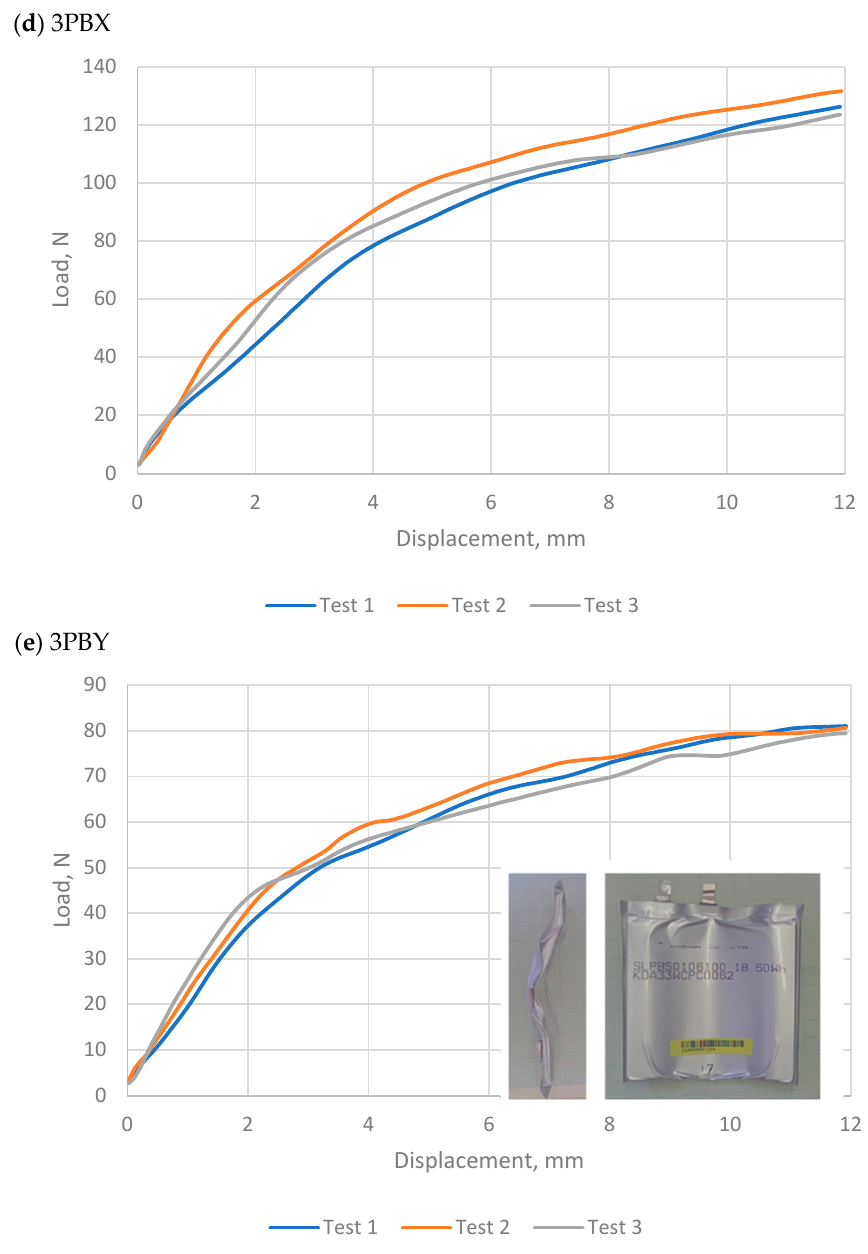
Figure 4. Typical load displacement curves from Dow Kokam SLPB5010600 pouch; ( a ) Lateral compression in Z ( b ) Confined compression in X, ( c ) Confined compression in Y (Insets—deformed cell and CT scan section of folds), ( d ) 3-point bend around X axis, ( e ) 3-point bend around Y axis (Inset deformed cell). All tests conducted at 50% SoC.